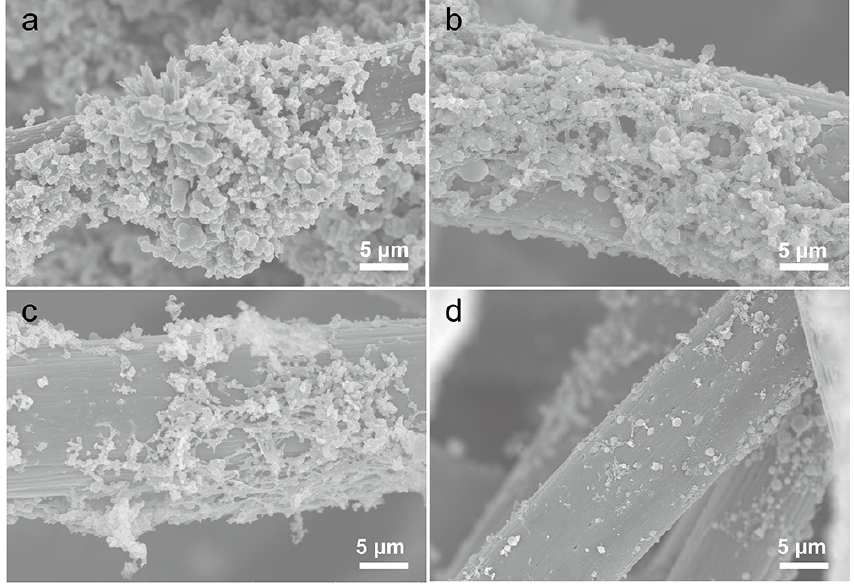
Figure 2. The SEM images of GF@PCNs electrode with various carbonized temperatures, ( a ) without carbonized process, ( b ) 800 °C, ( c ) 900 °C and ( d ) 1000 °C.